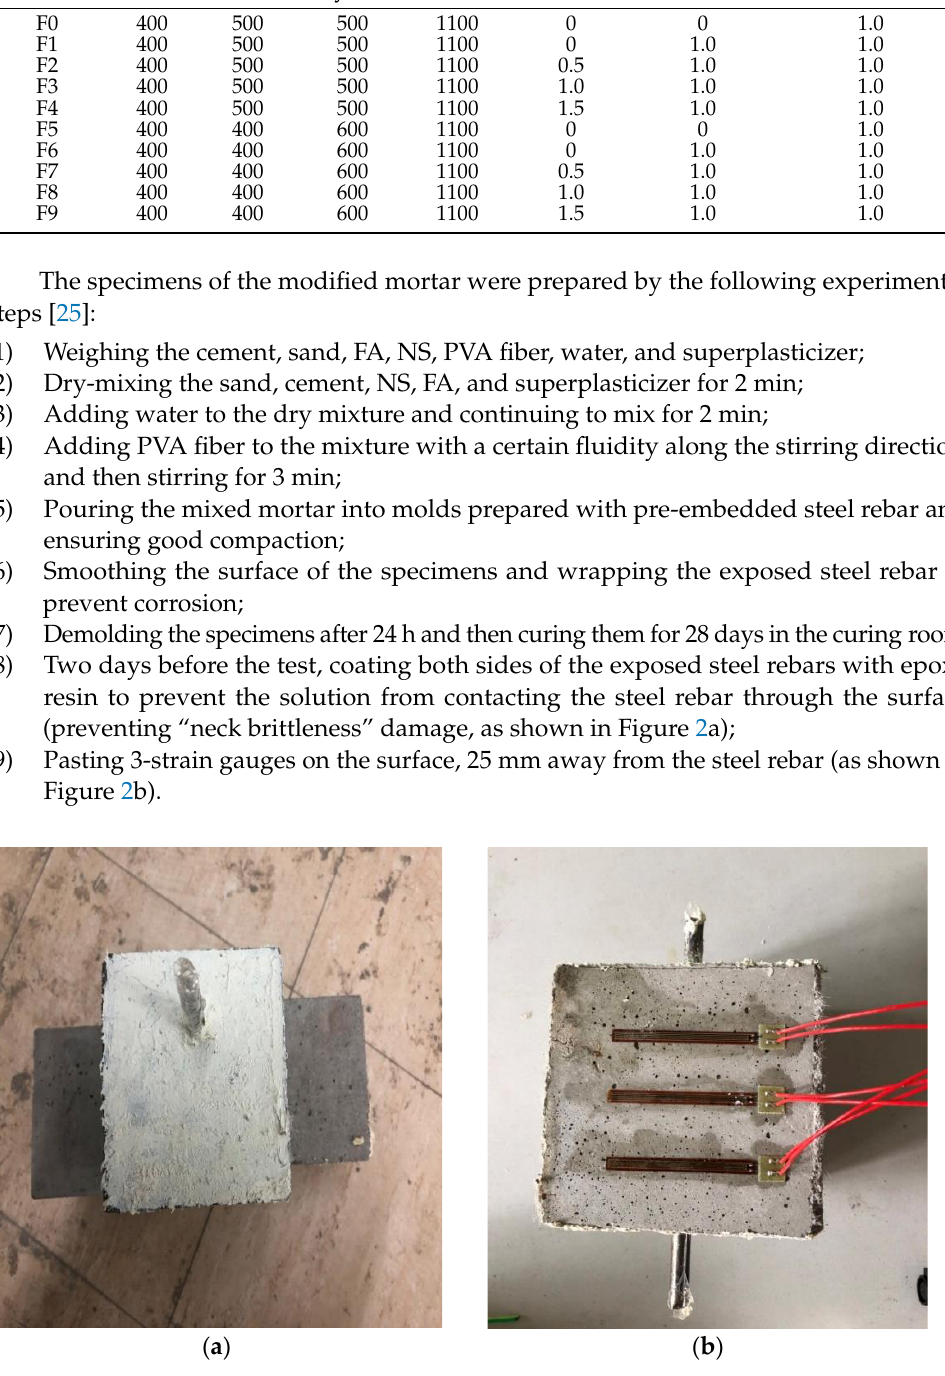
Figure 2. Test specimen ( a ) the side coated by epoxy, ( b ) 3-strain gauges on the surface.